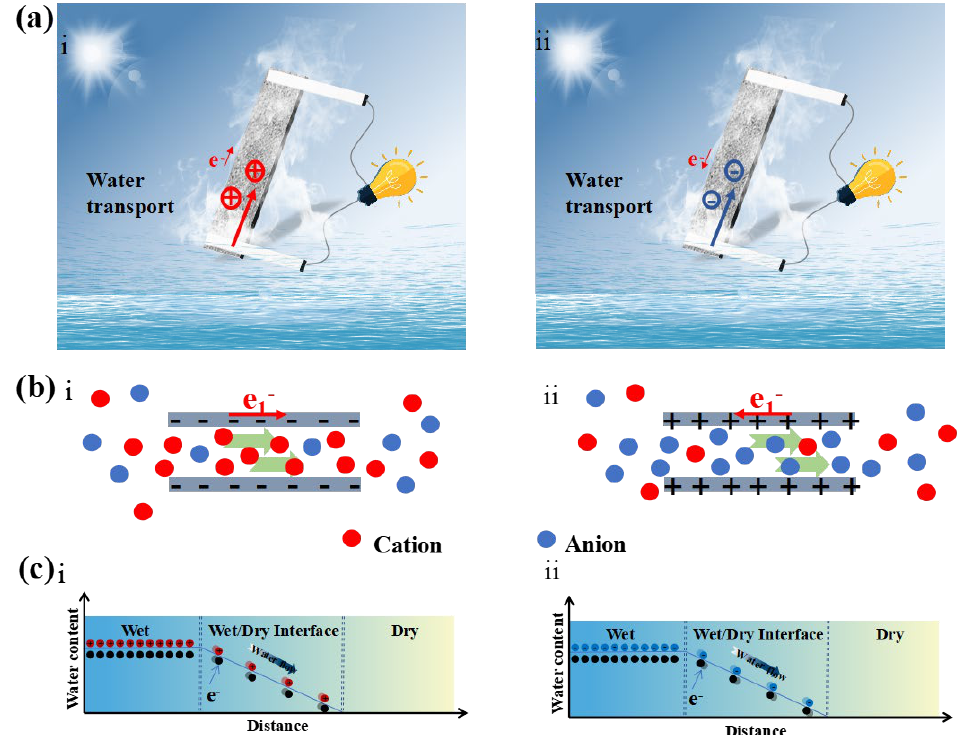
Figure 5. ( a ) Schematic of evaporation power generation of KBF (i) before and (ii) after modification; ( b ) Schematic of the ion-selective transport through a nanochannel before and (ii) after modification; ( c ) Mechanism of the current generation before (i) and after (ii) modification.